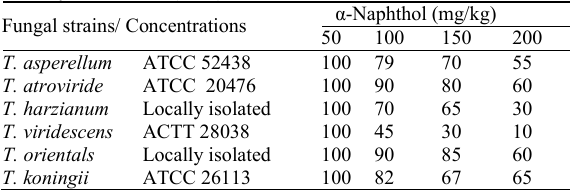
Table 1. Growth assessment of studied fungi in media containing various concentrations of α-naphthol based on colony diameter (mm) Fungal strains/ Concentrations